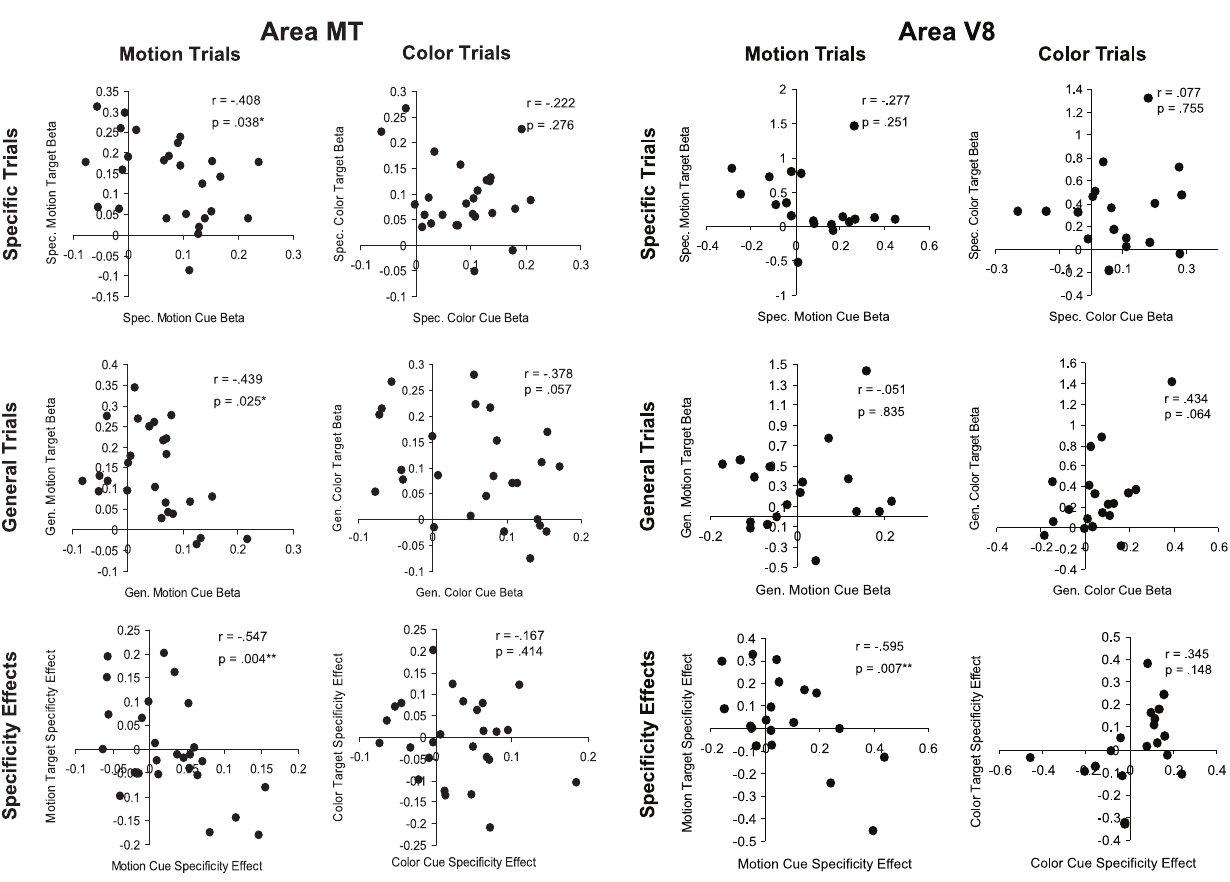
Figure 6. Cue-target correlations in area MT. The top row (Specifi c Trials) shows the correlation between specifi c feature cues and targets for motion (left) and color (right) attention conditions. The middle row (General Trials) shows the correlation between general dimension cues and targets for motion and color attention conditions. The bottom row (Specifi city Effects) shows the correlation between cues and targets for the effect of cue informa- tion (specifi c feature cue minus general dimension cue) for motion and color attention conditions.